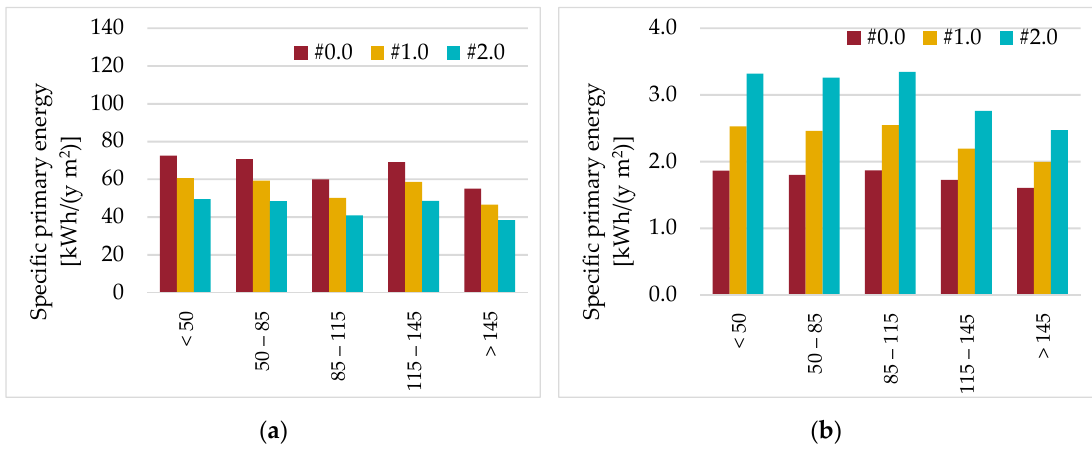
Figure 11. Florence: Specific primary energy consumption. ( a ) Heating; ( b ) cooling.